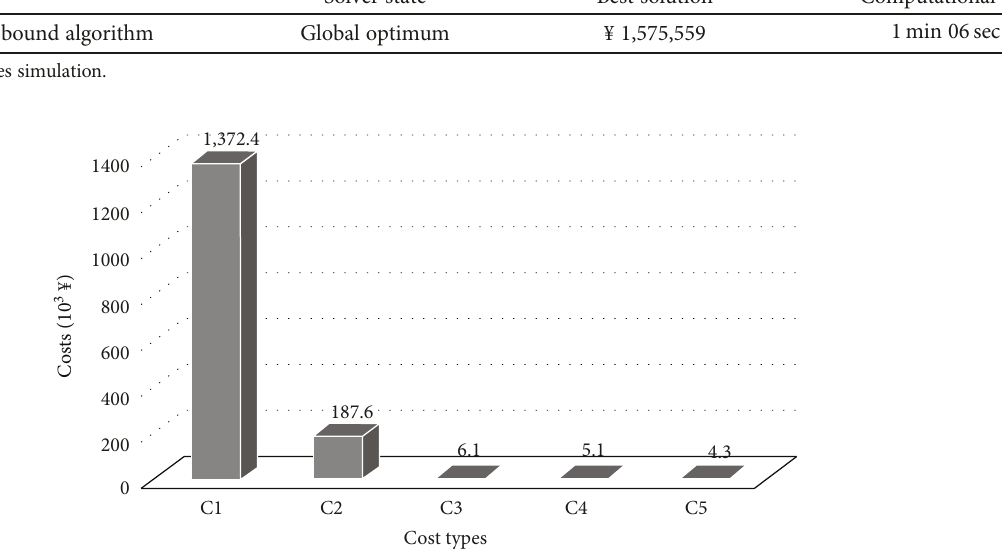
Figure 6: Structure of the minimal generalized costs. Table 6: Best routes in the empirical